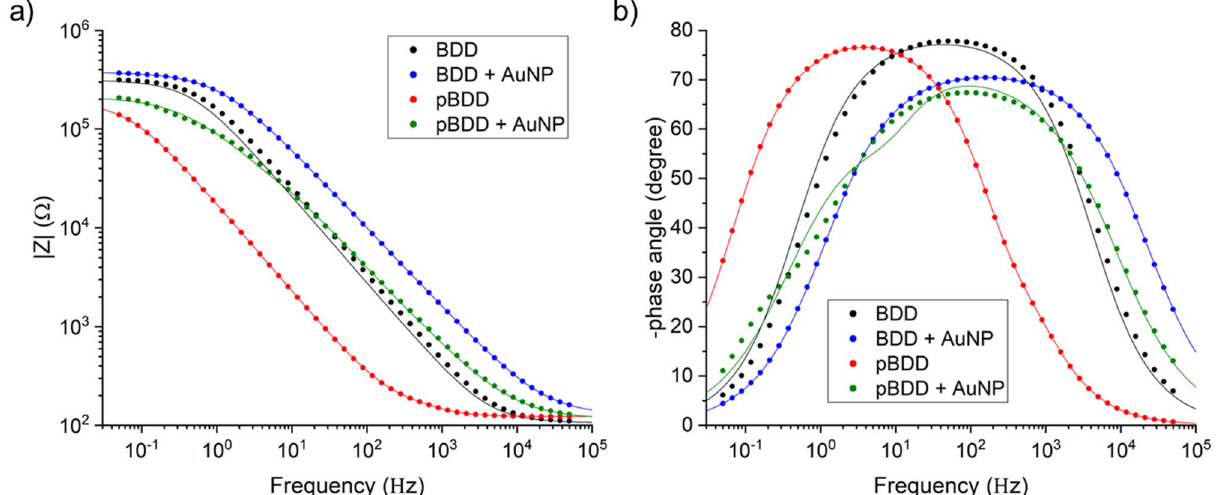
Figure 3. (a) The Bode impedance plots and (b) the Bode phase plots of the data for each electrode resulting from an EIS measurement performed at a mercury concentration of 1 mM, applied potential 0.35 V. The EIS measurement was conducted over the frequency range 50 kHz to 50 MHz, with 8 points per decade and 10 mV EIS measurements.